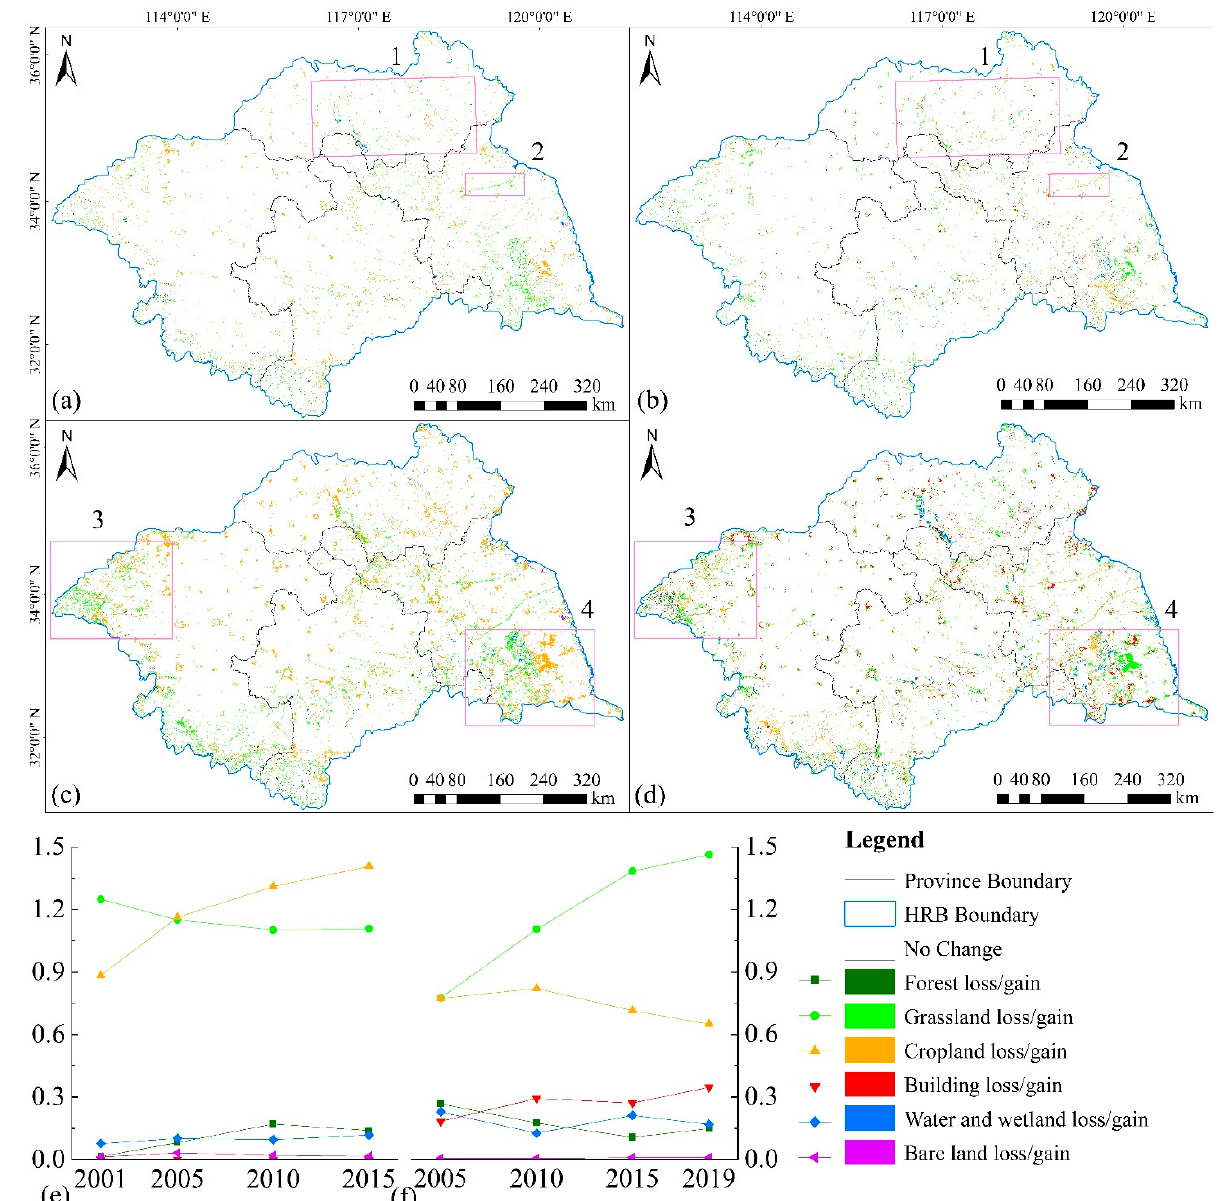
Figure 8. Land use transfer maps of the HRB representing ( a ) losses and ( b ) gains in land ‐ use types between 2001 and 2005, and ( c ) losses and ( d ) gains in land ‐ use types between 2001 and 2019. Proportion ( e ) loss and ( f ) gain of each land ‐ use type related to land ‐ use transfer each year.